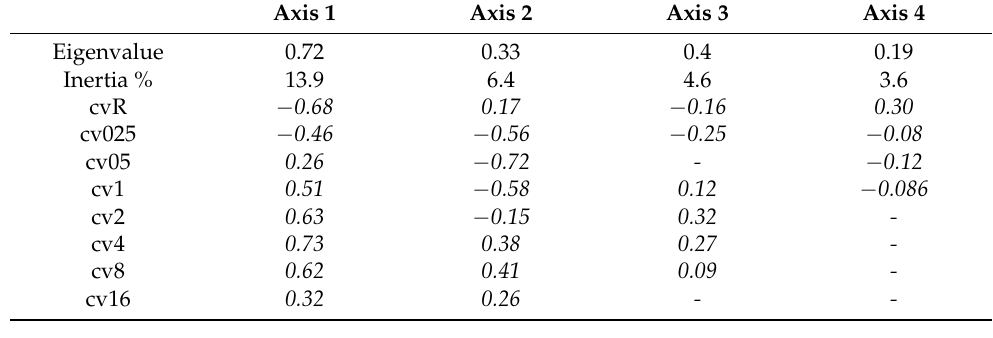
Table A2. Eigenvalues of the four first axes of the correspondence analysis of the bird matrix, and correlation of the axes with the rock cover and the vegetation covers.